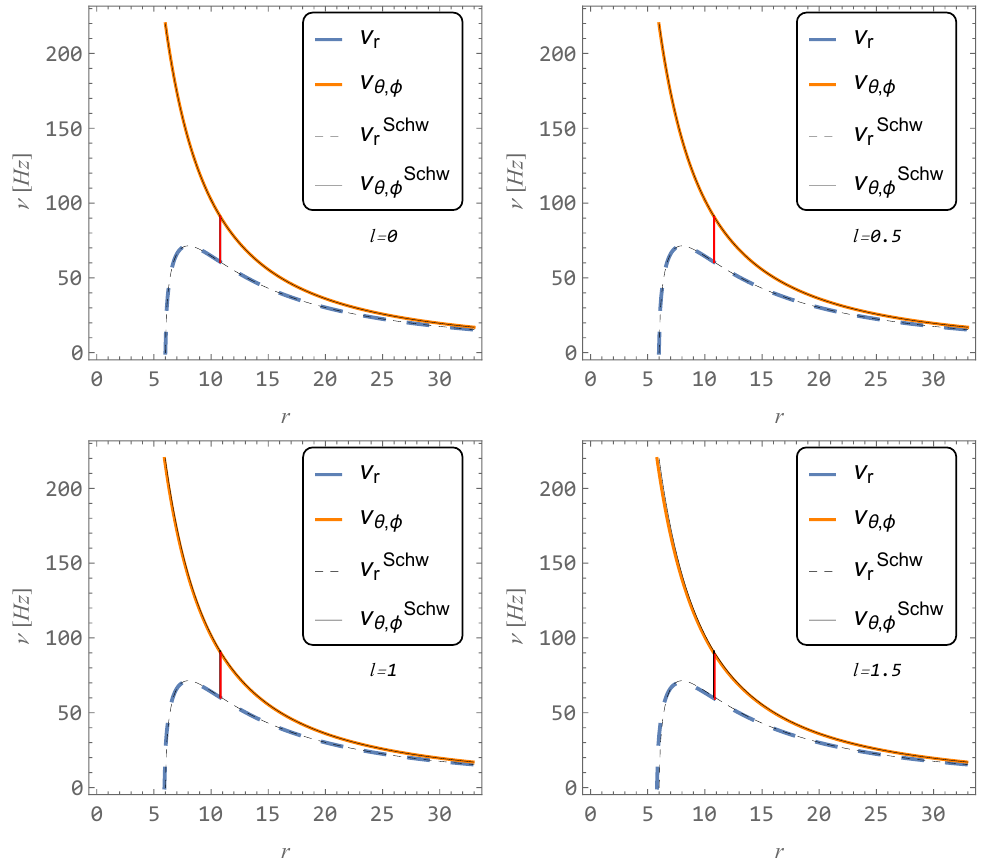
Figure 5. Epicyclic frequencies radial profiles for characteristic values of the parameter l in units of M giving regular black holes and M = 10 M (cid:12) . Vertical black line indicates frequency ratio 3:2 for Schwarzschild case and red for given l (here both vertical lines almost